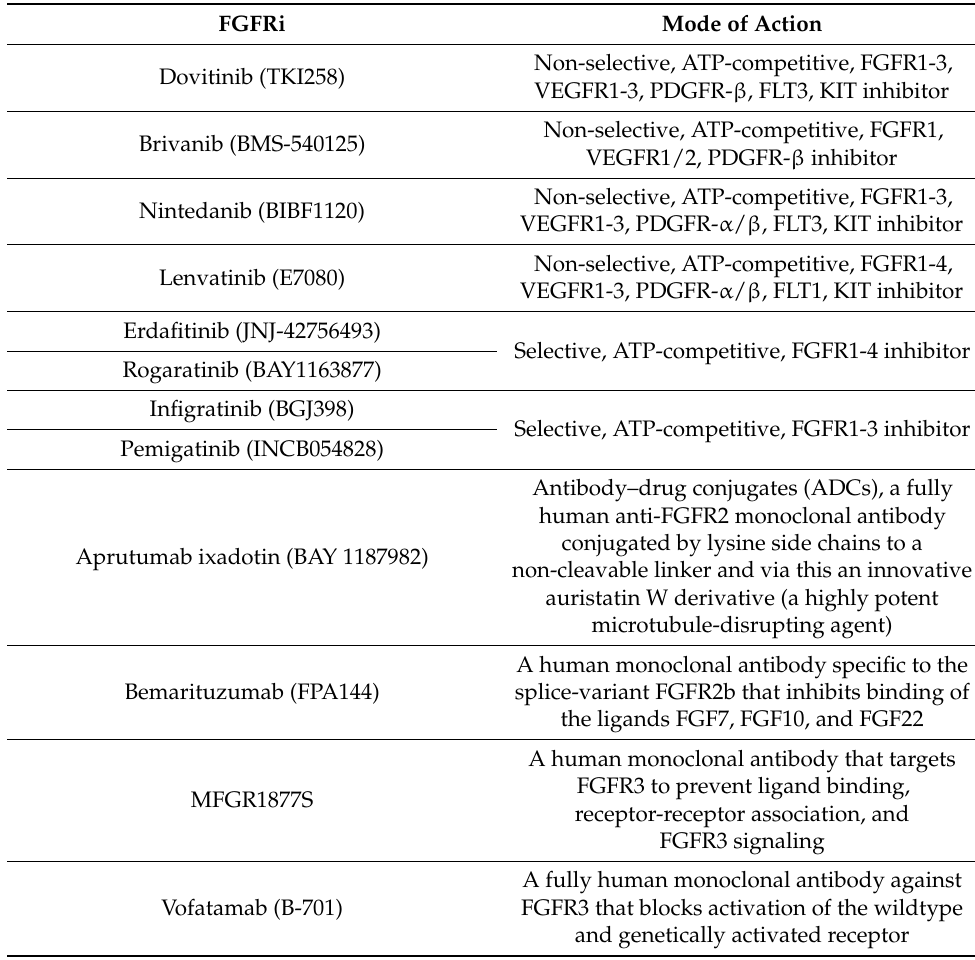
Table 1. Representative FGFRi’s as single anti-cancer